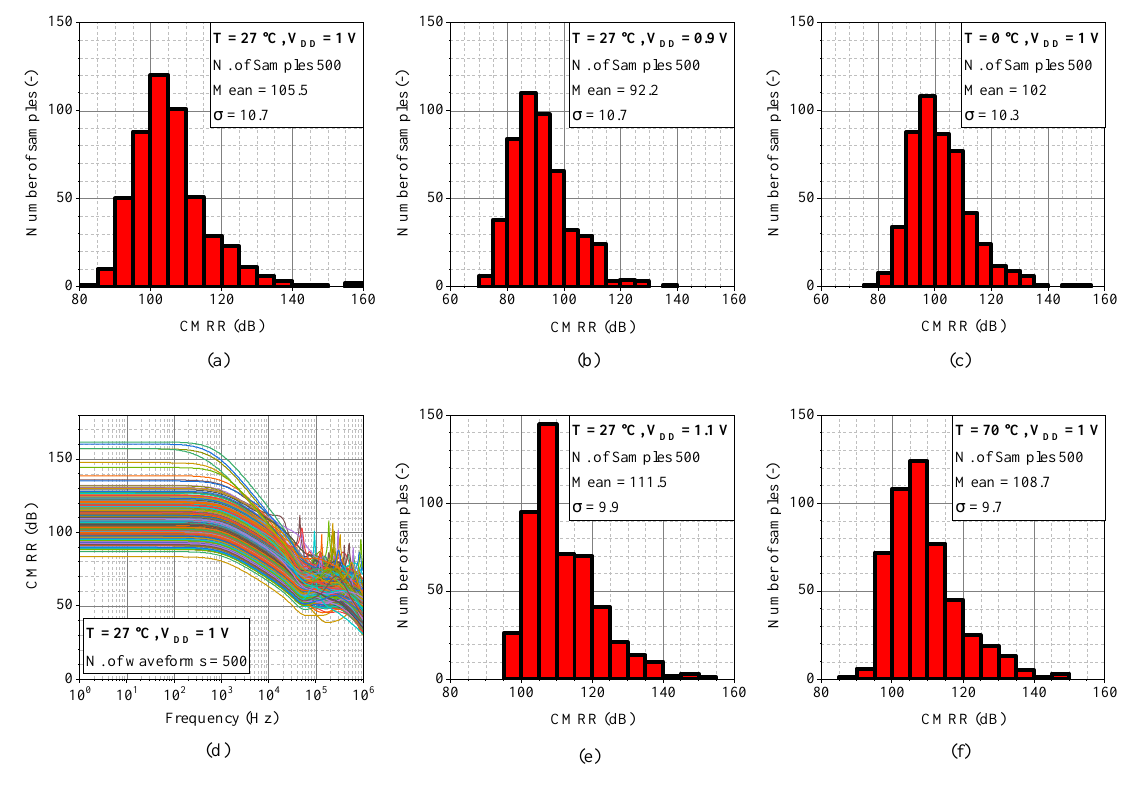
Figure 13. Analysis of CMRR for ( a – c , e , f ) different conditions by Monte Carlo and ( d ) typical AC response.